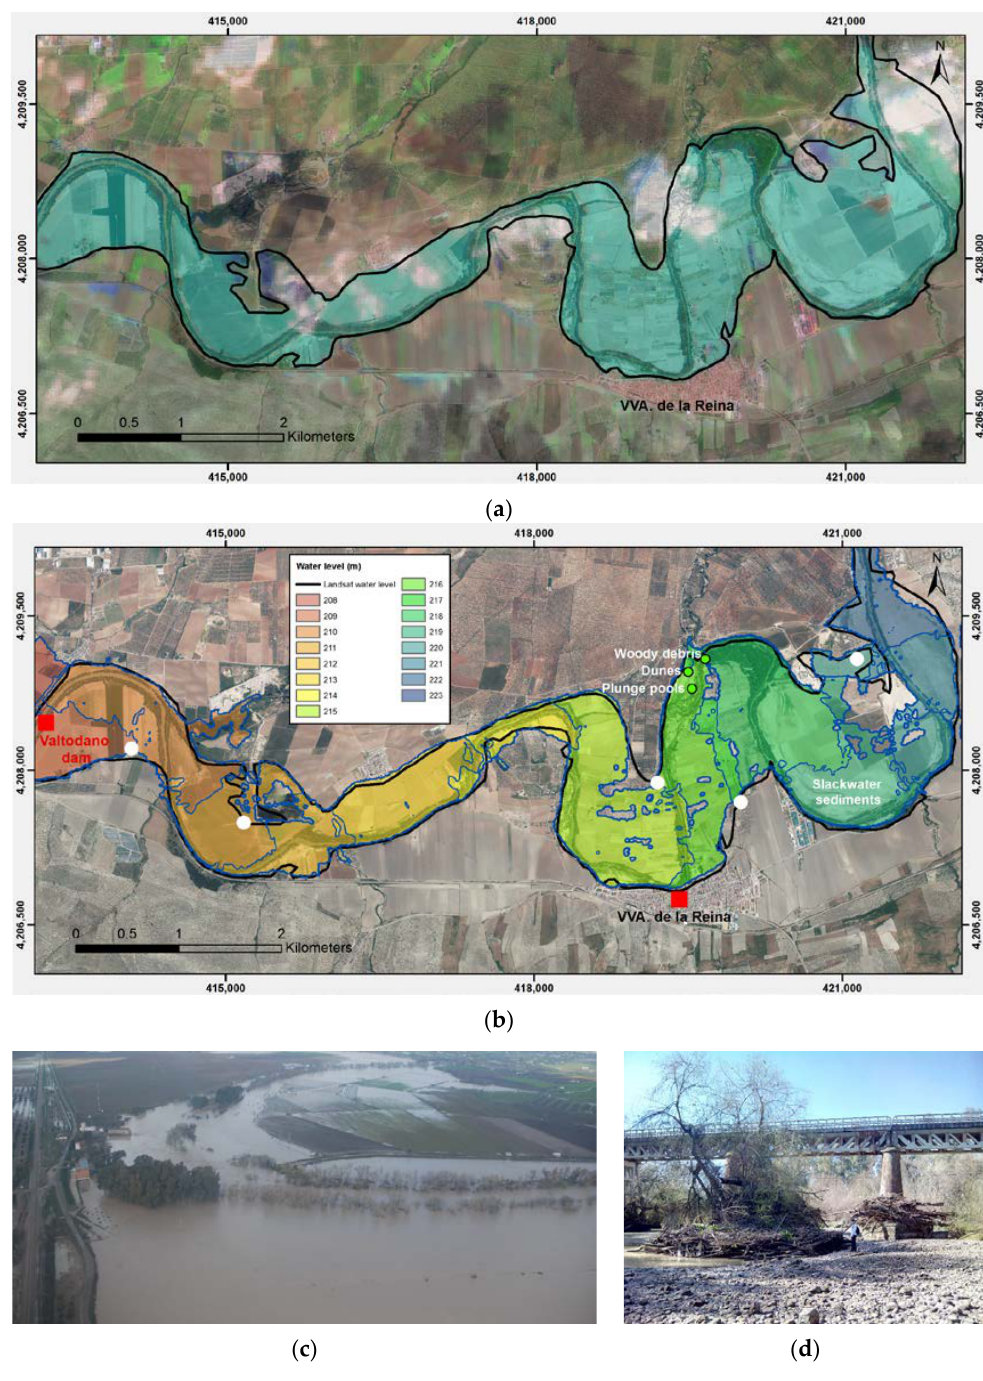
Figure 4. ( a ) Flooded area derived based on Lansat 5 data and corrected with flood photographs on 24 February 2010. ( b ) Numerical flood simulation superposed on Lansat wet perimeter. Colours indicate altitudes of water surface. Flow from right to left. The inundated town at the bottom is Villanueva de Reina. Stage indicators correspond with Figure 3. ( c ) Photograph of the overtopped Valtodano dam (see location in panel b ). ( d ) An example of botanical HWM-PSI. Person 1.85 m tall provides scale.